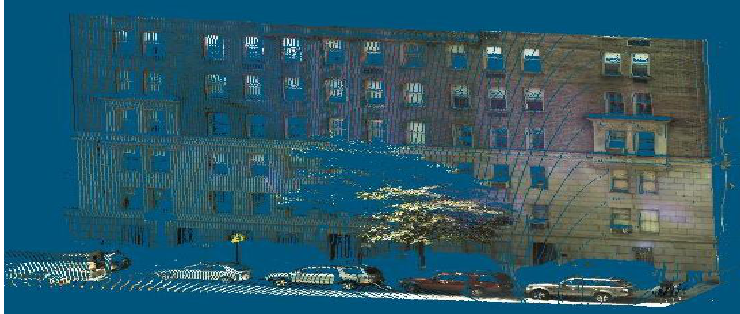
Figure 11. Segmentation and classification results for a particular scene-C of scenes from 3D Urban Data Challenge 2011, image # ParkAvenue SW14 piece00 [36]. (a) 3D data points—shows 3D data points of data set 1. (b) Voxelisation and segmentation into objects—shows s -voxel segmentation of 3D points (along with orientation of normals). (c) Labeled points—shows classification results (labeled 3D